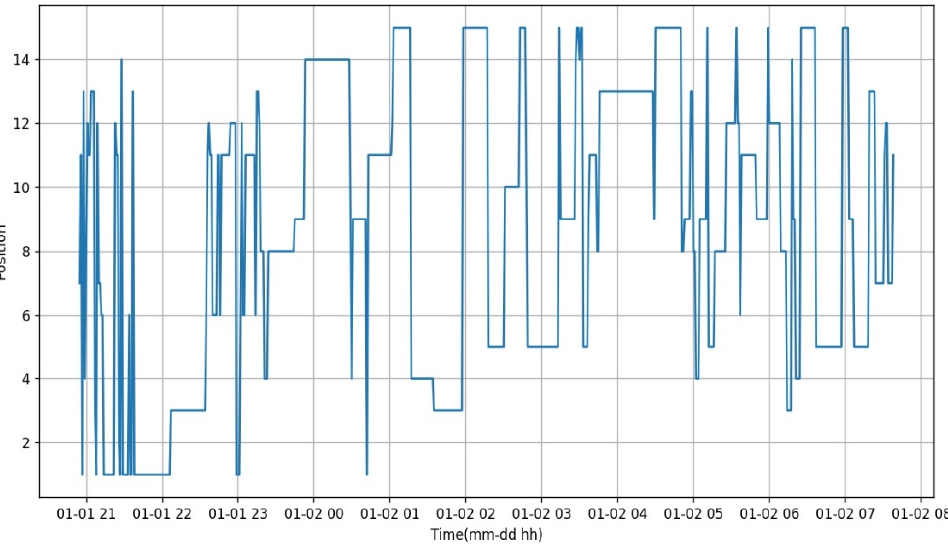
Figure 12. The distribution of the head position for a user.